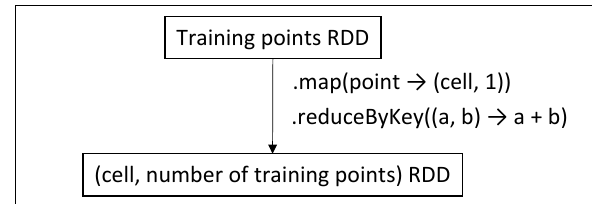
Figure 14. Create cell-training points RDD (Phase